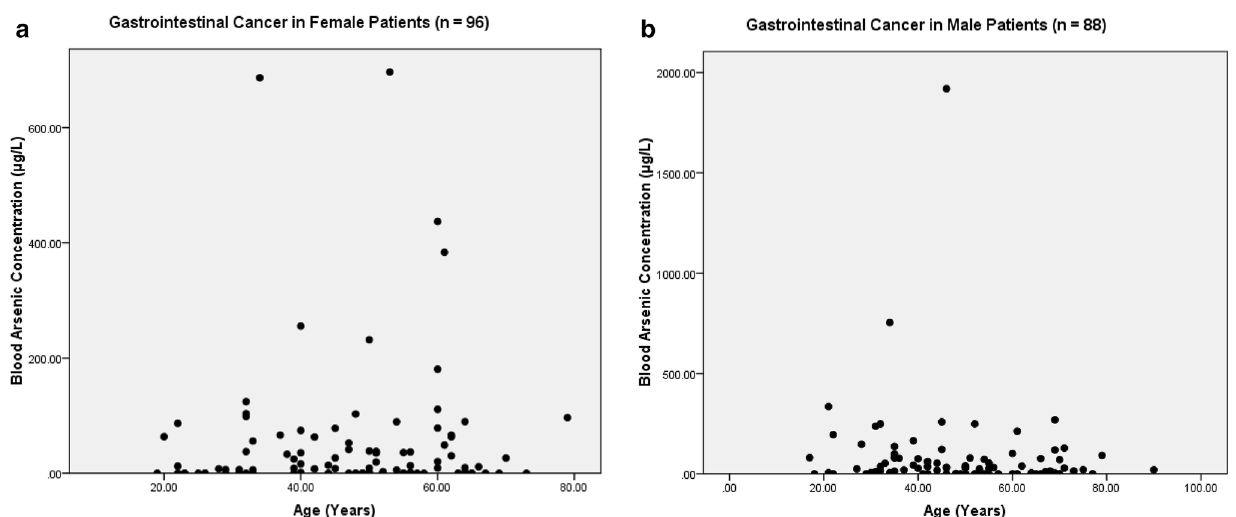
Figure 11. The correlation coefficient between blood arsenic levels and age of the female vs male gastrointestinal cancer patients (P <